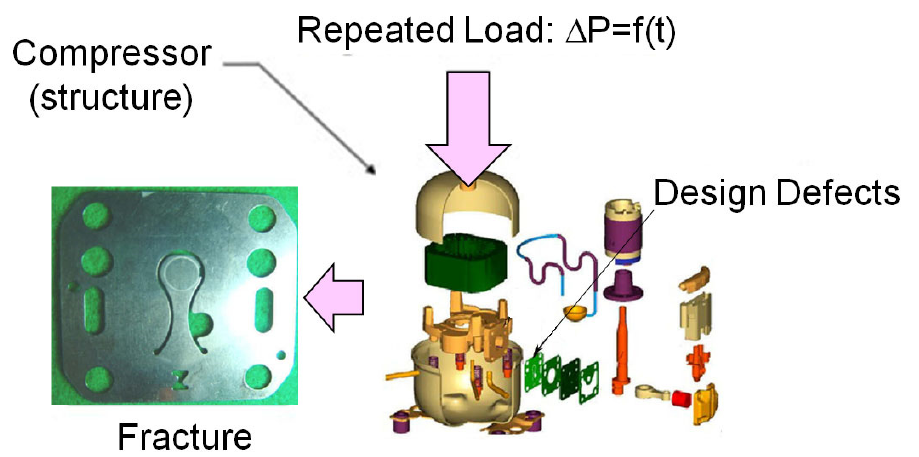
Figure 4. Fatigue failure on the structure created by repetitive loading and design flaws.